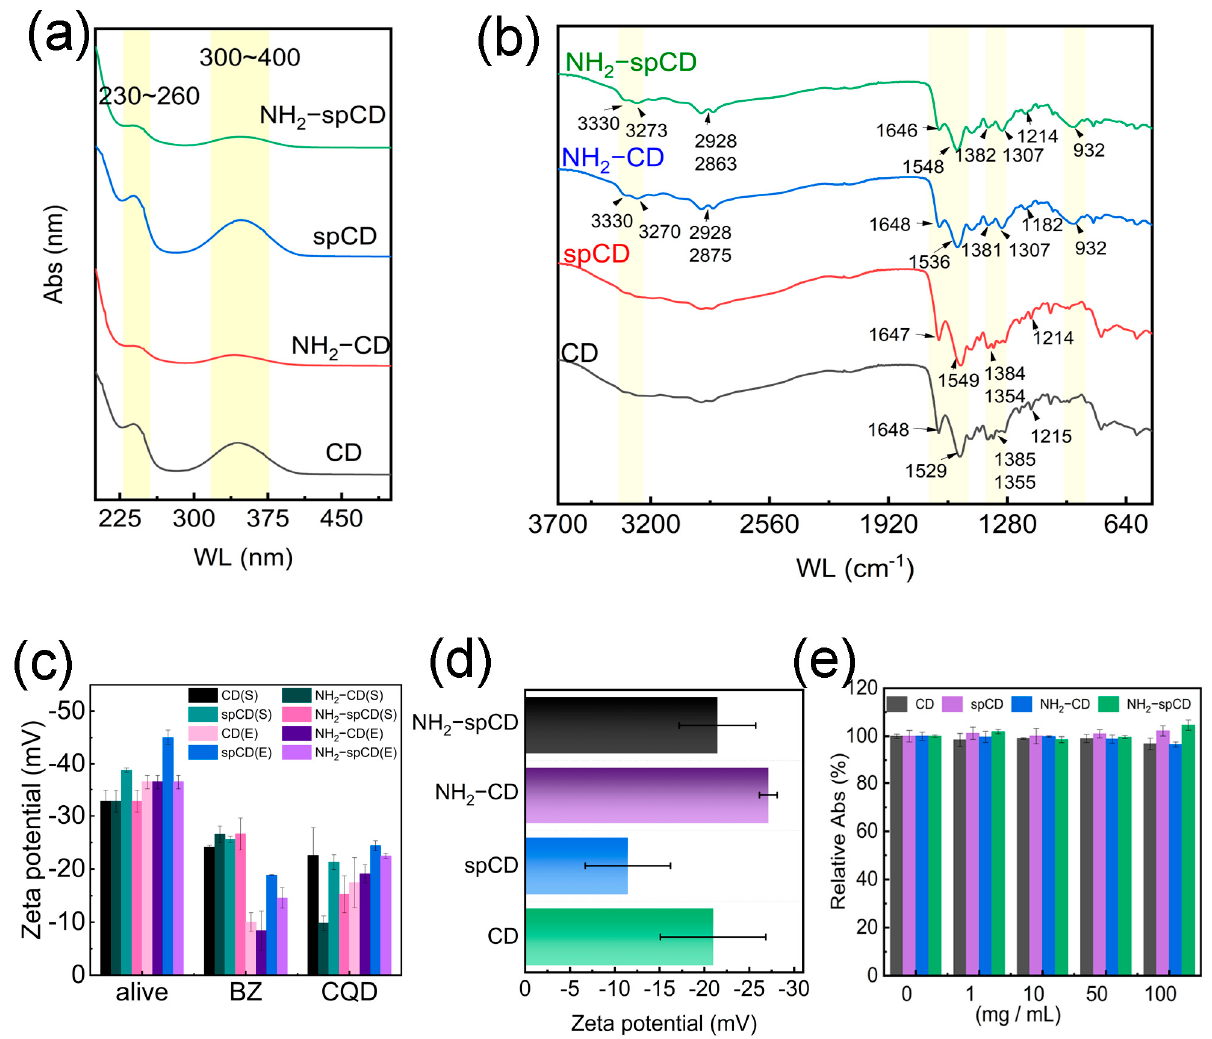
Figure 3. ( a ) UV–Vis spectra and ( b ) FTIR spectra of CD, spCD, NH 2 –CD and NH 2 –spCD, ( c ) Changes of zeta potentials after cultured with 3% BZ (BZ represent bacteria that cultured by benzalkonium bromide and QD represent bacterial cultured by corresponding carbon dots after cultured in benzalkonium bromide), ( d ) Zeta potentials of spCD, NH 2 –CD and NH 2 –spCD, ( e ) MTT results for CD, spCD, NH 2 –CD and NH 2 –spCD culturing with L929 cells. Unite of concentration was mg/mL.